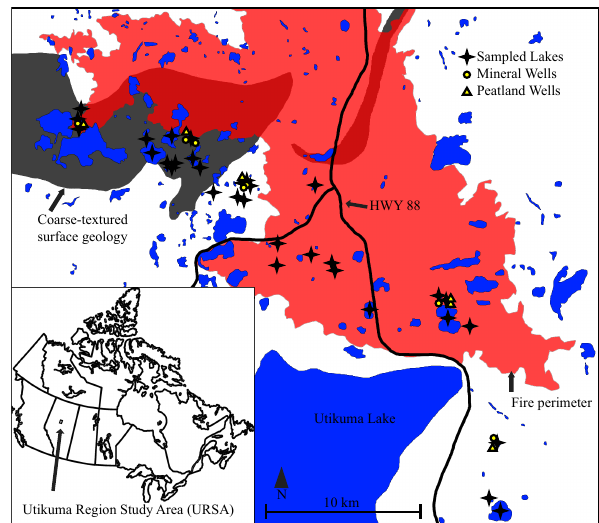
Fig. 1. Map of Utikuma Region Study Area (URSA) in north-central Alberta, Canada. Fire polygon retrieved from Canadian Forest Ser- vice (2011). North-eastern corner of Utikuma Lake is located at 55.92 ◦ N and 115.18 ◦